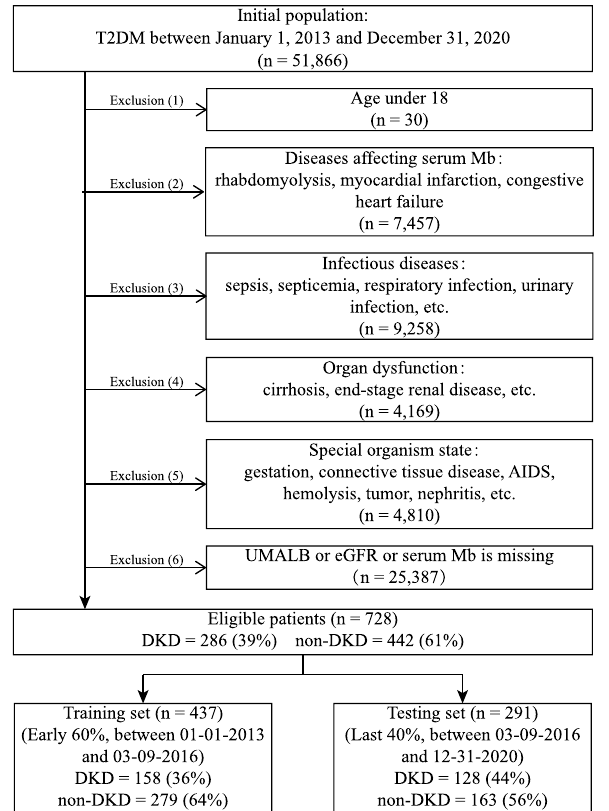
Figure 1. Inclusion and exclusion criteria of study population. Electronic health records (EHRs) of 51,866 hospitalized patients with type 2 diabetic mellitus (T2DM) were collected. Patients meeting the following exclusion criteria were removed: (1) under 18 years of age (n = 30), (2) diseases affecting serum myoglobin (Mb) (n = 7457), (3) infectious diseases (n = 9258), (4) organ dysfunction (n = 4169), (5) special body status (n = 4810), and (6) missing urine microalbumin (UMALB), estimated glomerular filtration rate (eGFR) and/or serum Mb data (n = 25,387). Finally, 728 patients were eligible for our study. The training set and testing set sample sizes were 437 and 291,